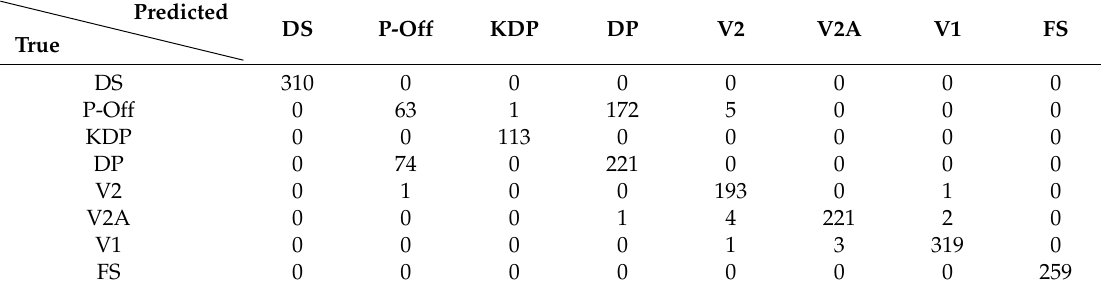
Table 18. Confusion matrix for the test set-1, in which the test subject performs one of the techniques of one of the XC-skiing styles repeatedly on a flat course at a time for the sports biomechanics configuration of sensors.